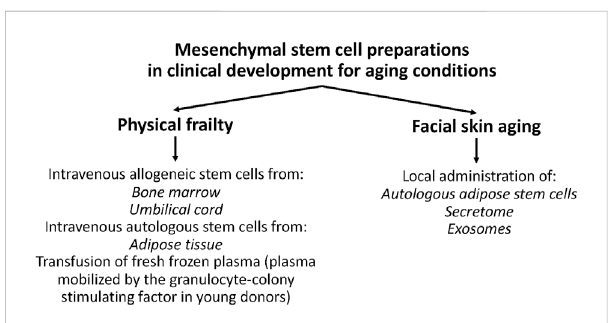
FIGURE 1 Mesenchymal stem cell (MSC) preparations in clinical development for aging conditions. MSC preparations are in development for physical frailty in older persons and facial skin aging. Reducing aging frailty can increase healthy life expectancy and decrease costs to the public health system. Clinical trials for facial skin aging are important because tissue regeneration is directly assessed bysophisticatedandprecisemethods,andbecausecellentrapmentin the lungs and safety issues of intravenous stem cells are